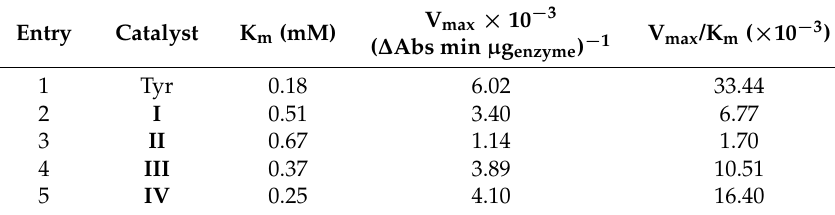
Table 4. Kinetic parameters of Tyr and catalysts I – IV a, b